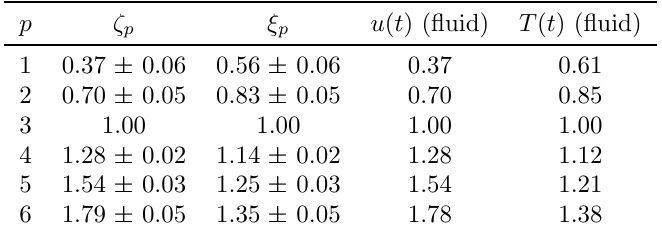
Table 1: Scaling exponents for velocity 𝜁 𝑝 and magnetic 𝜉 𝑝 variables calculated through ESS. Errors represent the standard deviations of the linear fitting. The data used comes from a turbulent sample of slow wind at 0.9 AU from Helios 2 spacecraft. As a comparison we show the normalized scaling exponents of structure functions calculated in a wind tunnel on Earth (Ru´ız-Chavarr´ıa et al. , 1995) for velocity and temperature. The temperature is a passive scalar in this